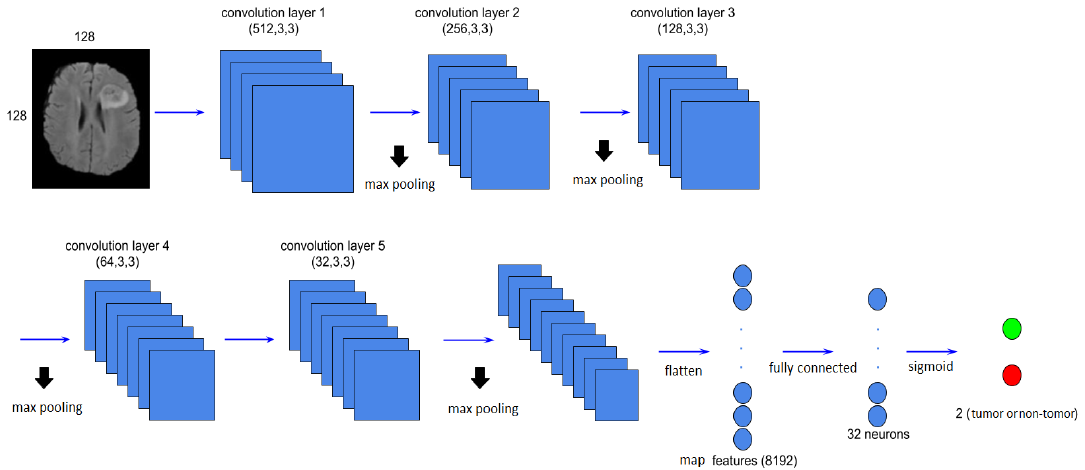
Figure 4. CNN architecture used in our approach.